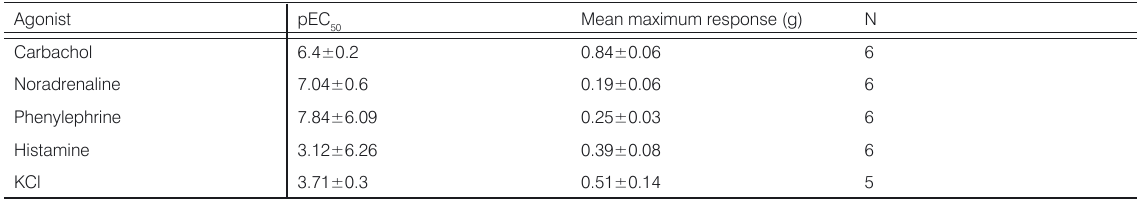
Table 1. The mean maximum responses and pEC values of the mouse urinary bladders in response to carbachol, noradrenaline, phenylephrine, 50 histamine and KCl administration. Agonist pEC